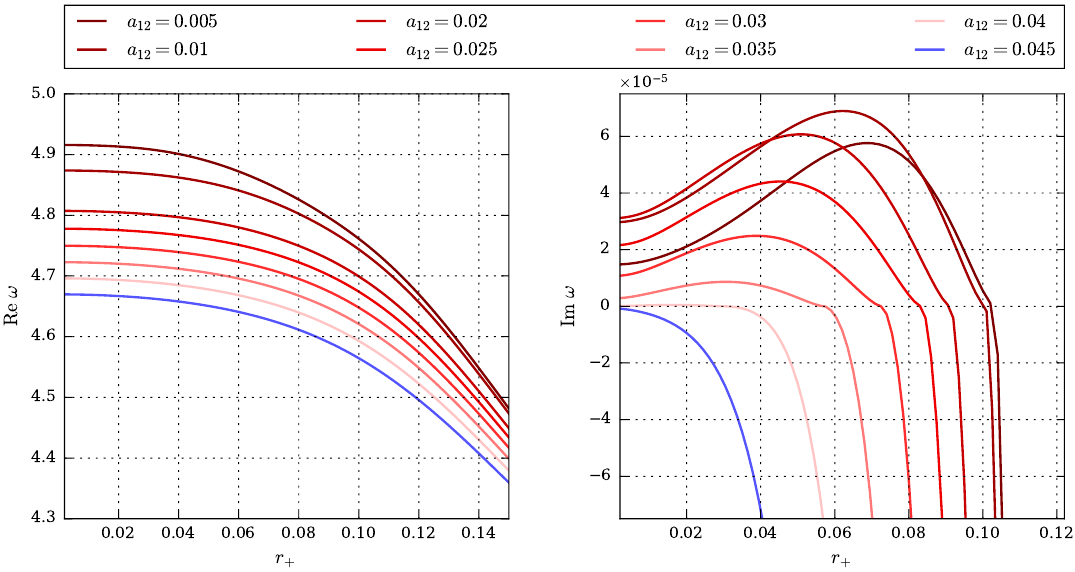
Figure 6 . The frequencies of the unstable modes for ‘ = 1 as a function of r + for various values of a 12 = a 2 − a 2 . Note that the superradiant window induced by the condition = θ + < 0 becomes 1 2 smaller with increasing a 12 due to the larger reduction of the real part of the eigenfrequency.